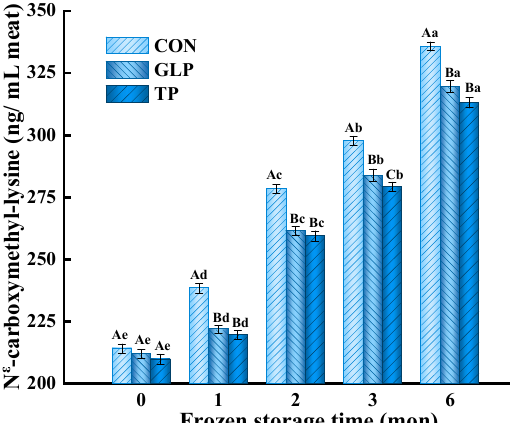
Figure 4. Effect of guava leaf polyphenols on the N ε -carboxymethyl-lysine content of frozen chicken meatballs. GLP, guava leaf polyphenols; TP, tea polyphenol; CON, control. The means at the same frozen storage with different uppercase letters (A–C) differ significantly ( p < 0.05); the means at the same polyphenol processing with different lowercase letters (a–e) differ significantly ( p < 0.05). The results are means ± SE ( n = 3).